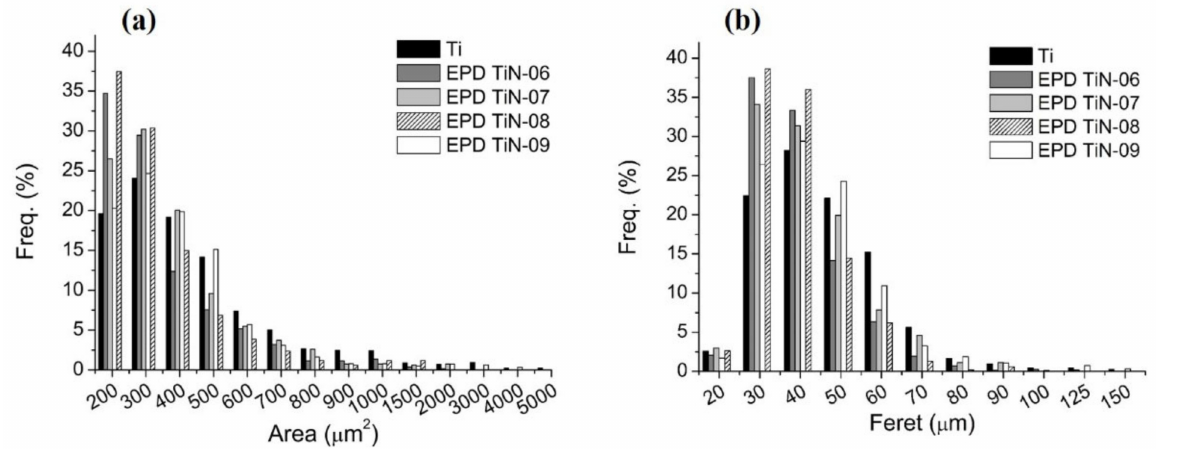
Figure 9. Statistical analysis performed on microscope images to evaluate residual porosity after EPD treatments. Frequent distribution of ( a ) pores’ area and ( b ) pores’ Feret diameter.